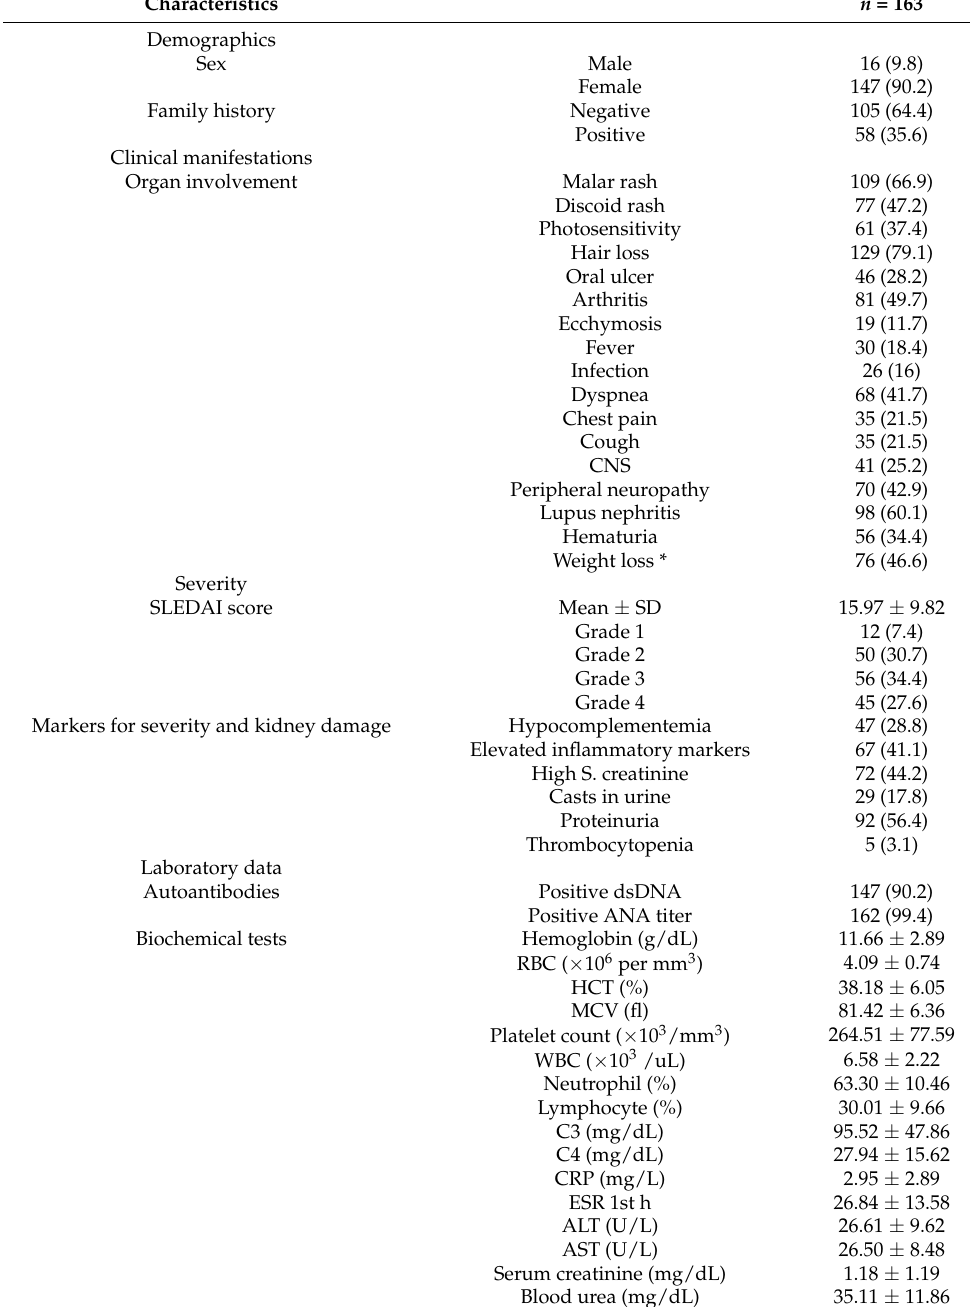
Table 1. Baseline characteristics of SLE